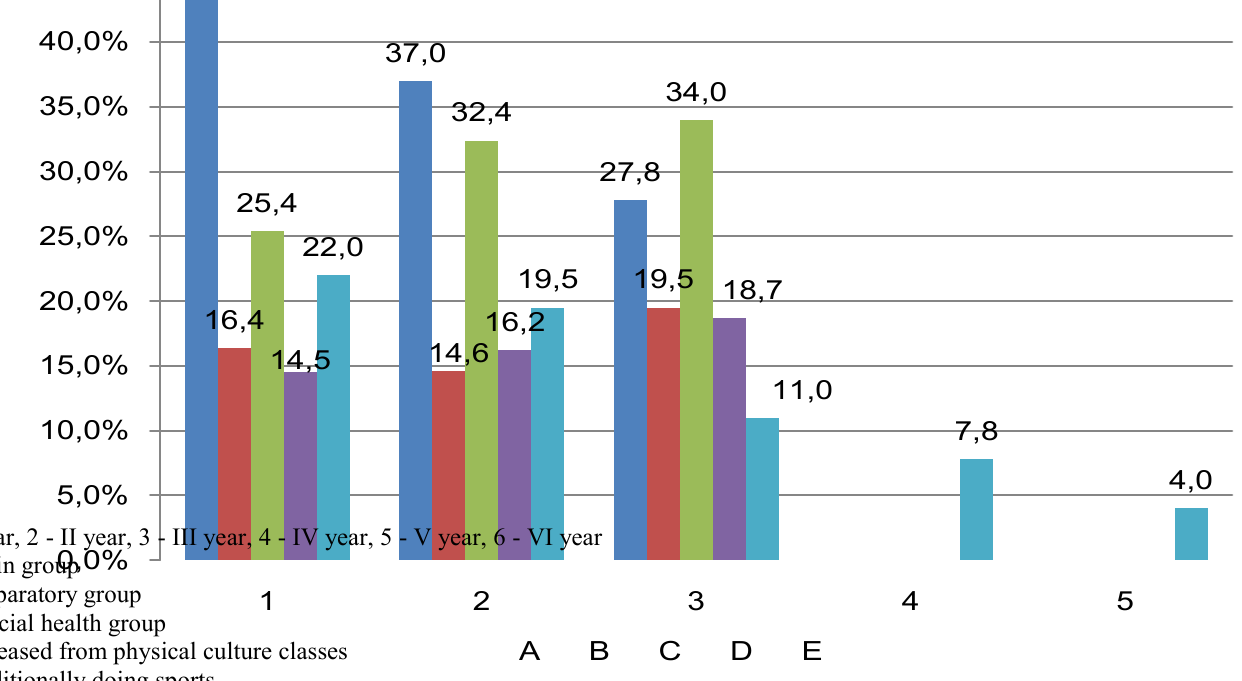
Fig. 4. Dynamics of students’ distribution among health groups and the students, who additionally do